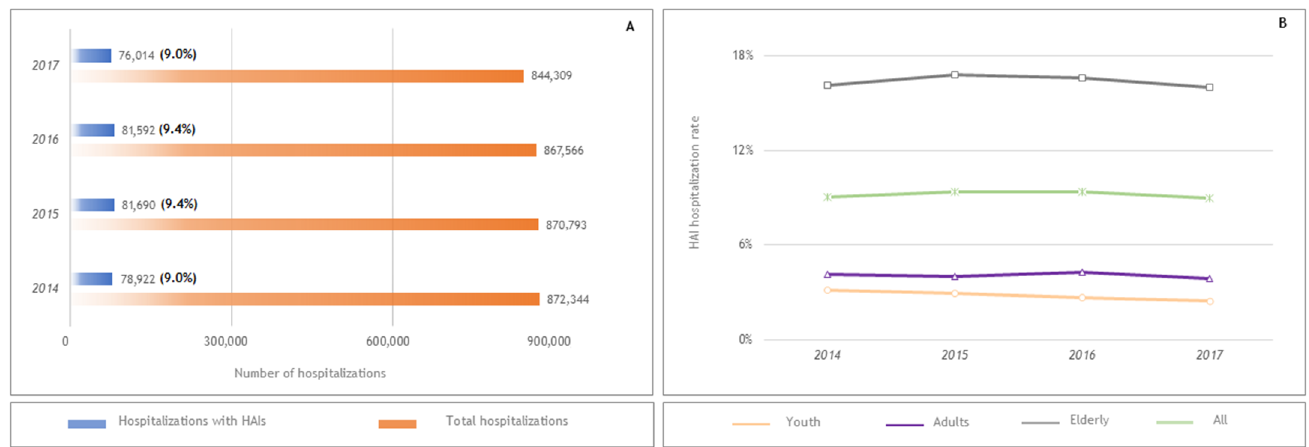
Figure 1. ( A ) Yearly number of hospitalizations with Hospital Acquired Infections and the total number of hospital admissions. ( B ) HAI hospitalization rate per age category.